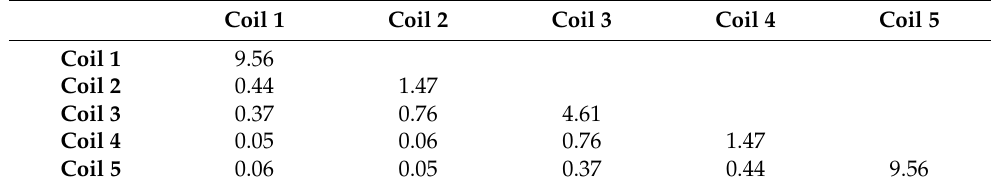
Table 4. Inductance matrix of the five coils.